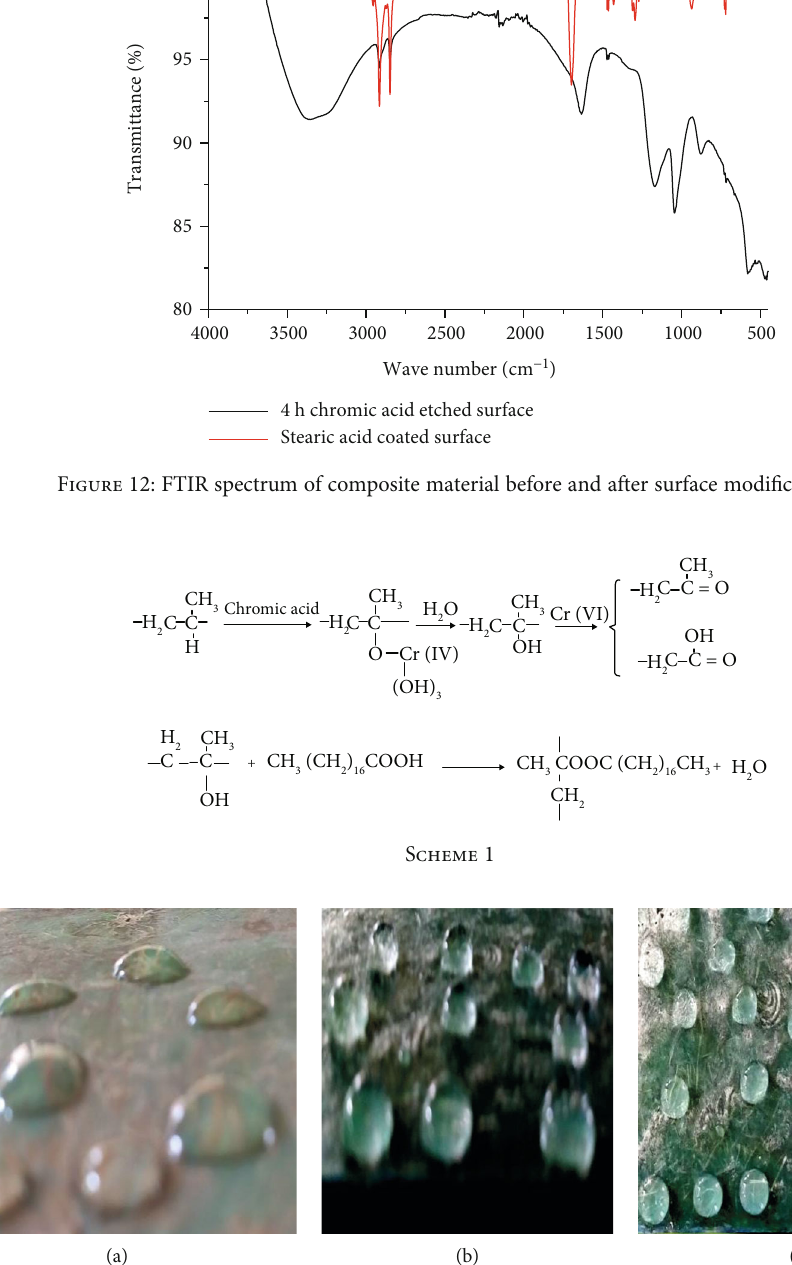
Figure 13: Water droplets on composite material (a) before surface modi fi cation, (b) chromic acid etched, and (c) stearic acid- modi fi ed